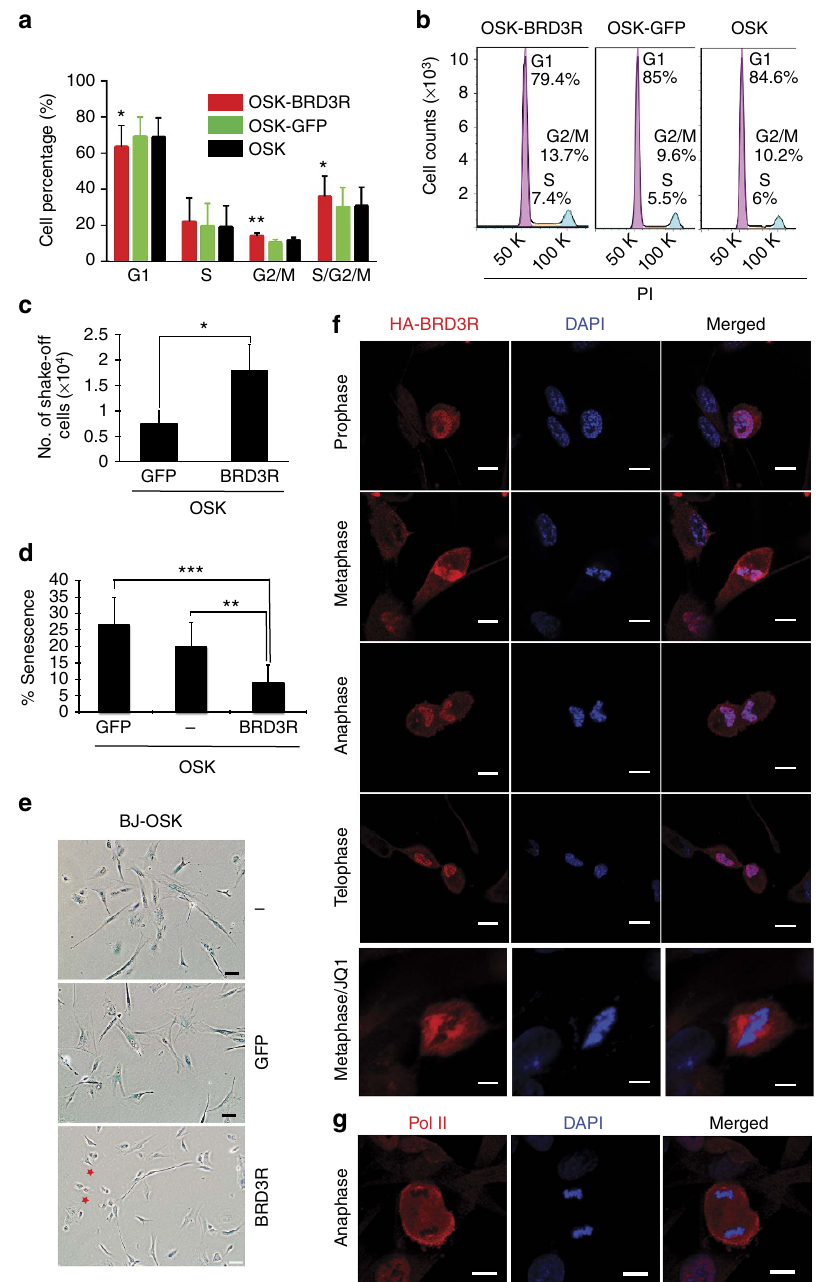
Figure 6 | BRD3R regulates mitosis during reprogramming. ( a ) BRD3R increases cell population in M phases on day 6 of reprogramming (mean ± s.d., n ¼ 3; * P o 0.05; ** P o 0.01; t test). ( b ) Representative flow cytometry histograms from experiments in ( a ). Cell cycle analysis was performed